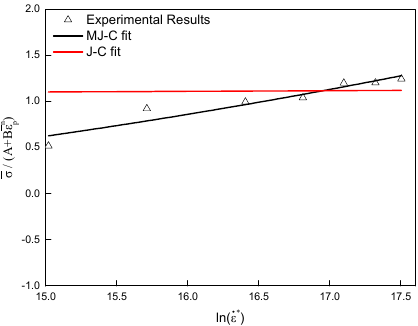
(cid:16) (cid:17) . ε ∗ A + B ε n and σ / at the reference temperature. P